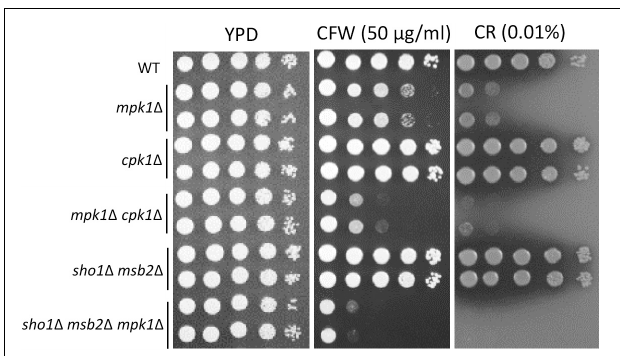
FIGURE 8 | Sho1 and Msb2 have a redundant role in regulating cell wall integrity. Wild-type (WT; H99), mpk1 (cid:49) (YSB3814 and YSB3816), cpk1 (cid:49) (YSB127 and YSB128), mpk1 (cid:49) cpk1 (cid:49) (YSB6089 and YSB6091), sho1 (cid:49) msb2 (cid:49) (YSB3605 and YSB3606), and sho1 (cid:49) msb2 (cid:49) mpk1 (cid:49) (YSB6675 and YSB6676). Each strain was grown overnight at 30 ◦ C in YPD medium, 10-fold serially diluted, and spotted onto YPD medium containing the indicated concentrations of Congo red (CR) and calcofluor white (CFW). The plates were further incubated for 2–3 days and photographed. This spot assay was repeated more than three times and one representative image was shown